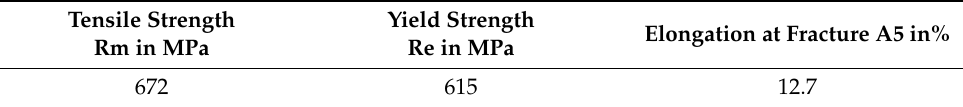
Table 2. Physical properties of S355 J2C + C according to the datasheet of the manufacturer. Tensile Strength